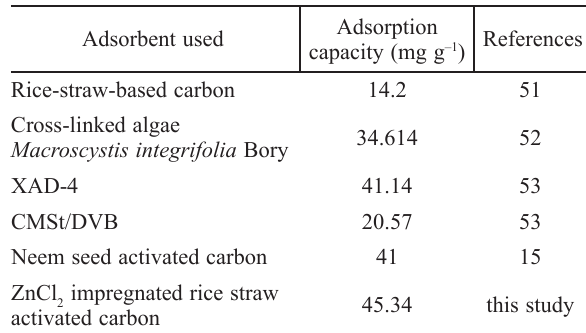
Table 7 – Comparative study of the 2-CP uptake capacity by various adsorbents Adsorbent used